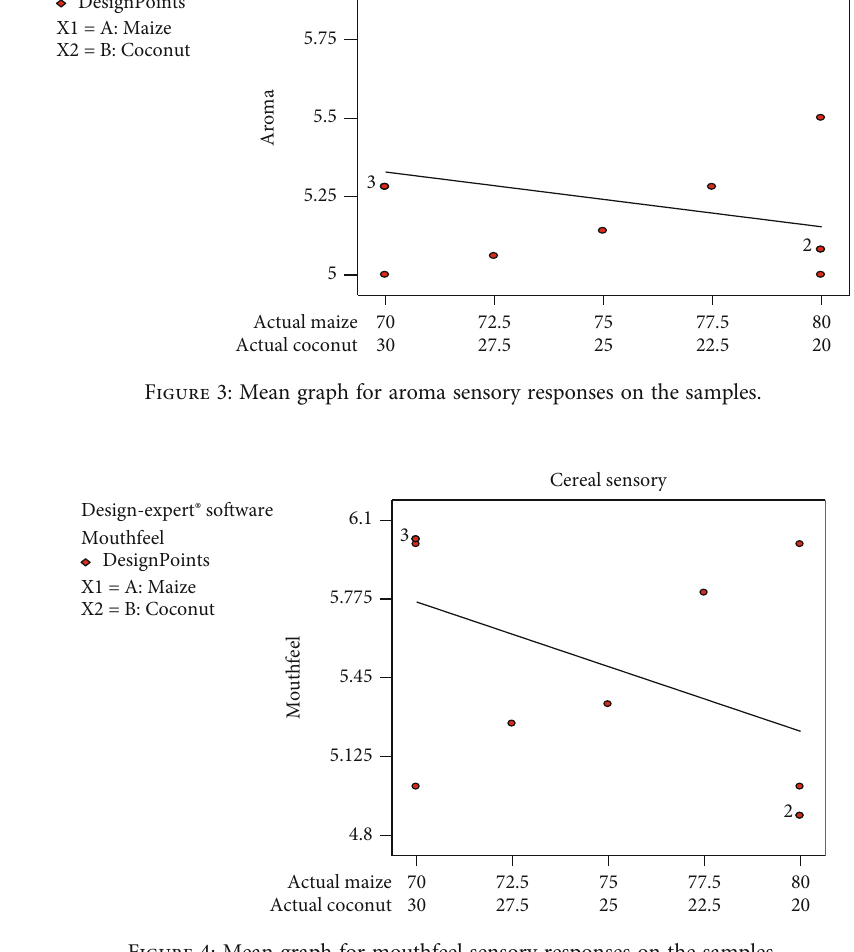
Figure 4: Mean graph for mouthfeel sensory responses on the samples.